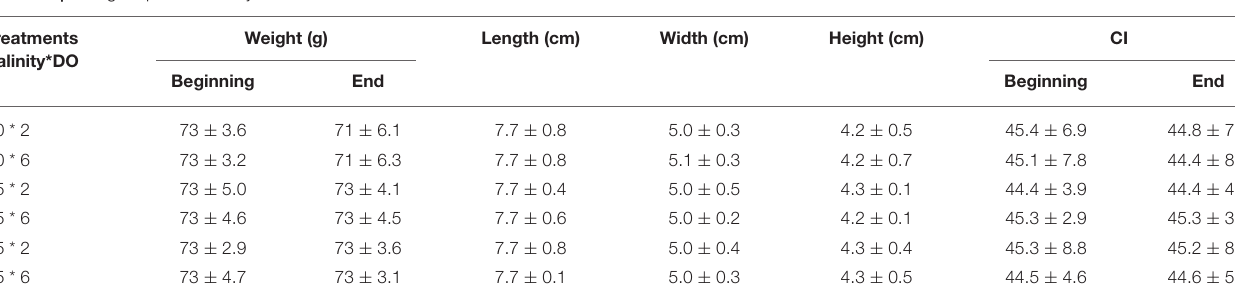
TABLE 2 | Biological parameters